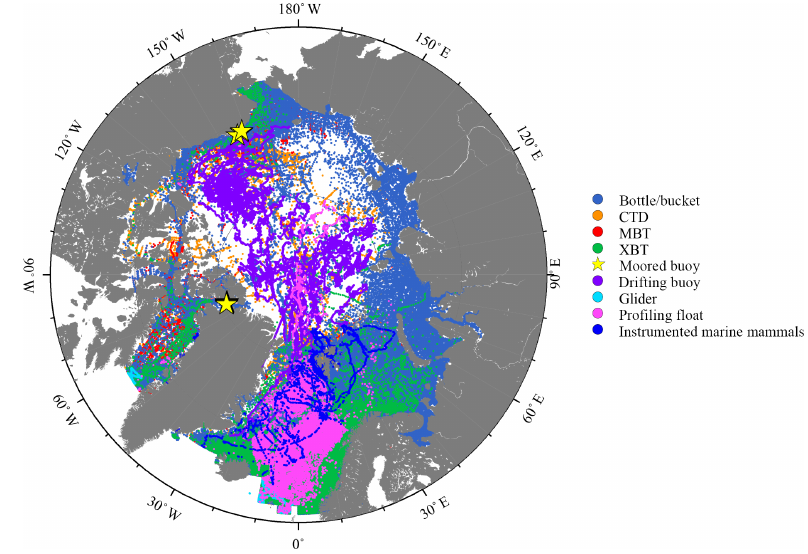
Figure 5. Data distribution by